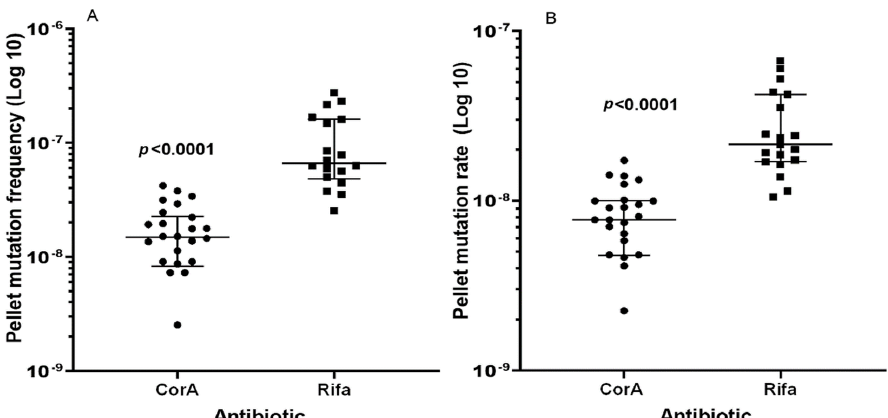
Figure 1. Spontaneous mutations leading to resistance against CorA and Rifa using plated pellets. ( A ) FoM to CorA and Rifa resistance, ( B ) corresponding mutation rates calculated using the Lea–